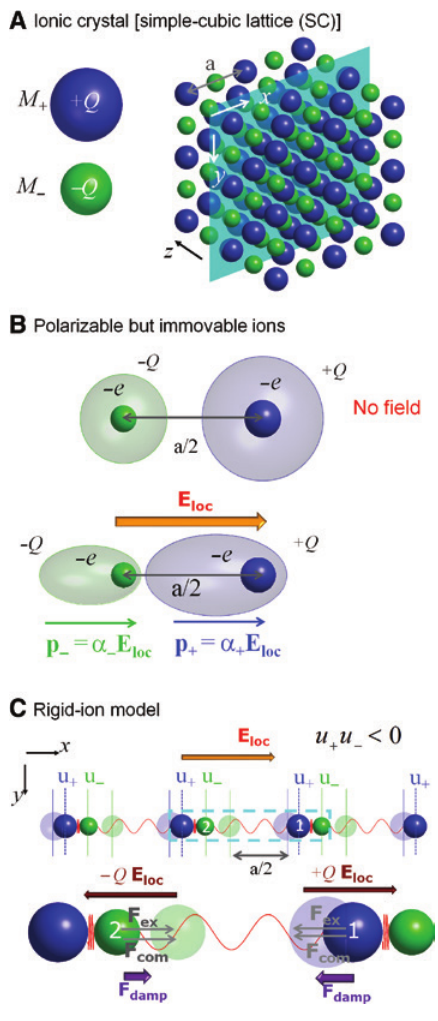
Figure 4: The ionic lattice and its response under the local electric field in the immovable-ion and rigid-ion models. (A) A simple cubic ionic lattice of lattice constant, a, comprising positive ions of mass M and charge + Q and negative ions of mass + M and charge – Q . (B) Dipole moment contributions, p and p of + − − each of the deformable ion types assuming they are immovable. The displaced electron clouds around the ionic cores under the influence of the local electric field E are shown. (C) The ions moving as loc rigid, non-deformable ions, under the influence of the local electric field E and elastic restoring forces coming from the extended and loc compressed “inter-ionic springs”, F and F . A diatomic chain of ex com the ions at certain depth, y , of the cubic lattice is depicted, where the positive (negative) ions are displaced from their equilibrium positions by u ( u ). The equilibrium positions for each ion type are + − designated with respective faint colored spheres. The bottom panel, is a zoomed depiction of the section within the cyan dashed lines, with the relevant forces in each kind of ions depicted. Damping forces, are also present (designated as F damp